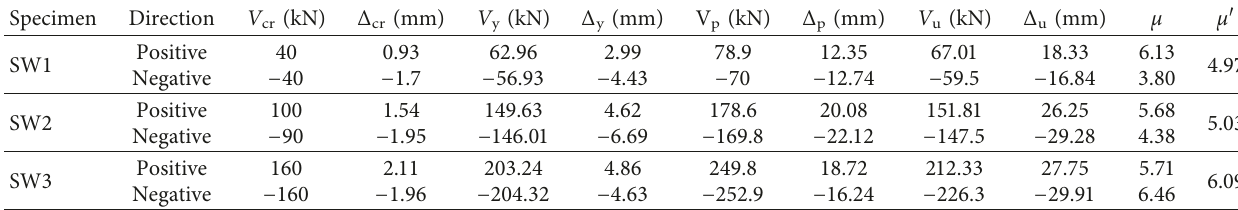
Table 3: Data of the cyclic lateral test.